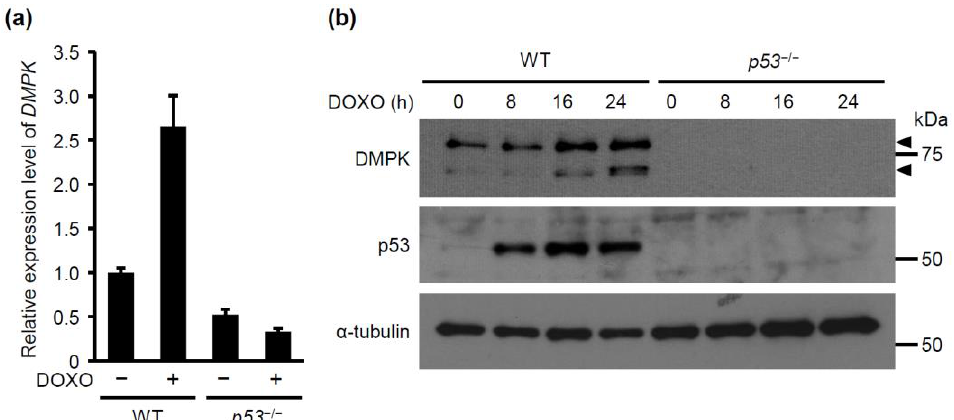
Figure 1. DMPK expression is upregulated upon DOXO treatment of p53 +/+ but not p53 −/− MEFs. ( a ) DMPK expression in p53 +/+ (WT) and p53 −/− MEFs treated with or without doxorubicin (DOXO; 0.5 μ g/mL) for 24 h was evaluated by qRT-PCR. Each bar represents the mean ± SD; n = 3. ( b ) Lysates from the cells treated with or without DOXO for the indicated time periods were subjected to immunoblot analysis with antibodies against DMPK, p53, and α -tubulin as a loading control. Arrowheads indicate DMPK.